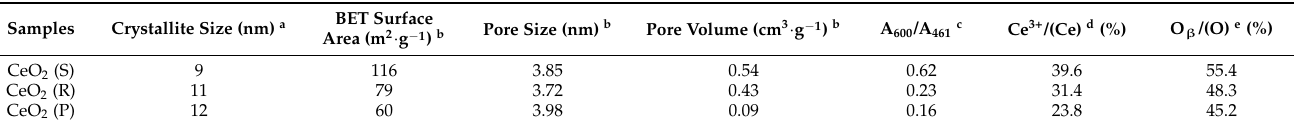
Figure 1. XRD patterns ( a ) and N 2 adsorption – desorption isotherms, BJH pore distribution (inset) ( b ) of CeO 2 (S), CeO 2 (R) and CeO 2 (P). Table 1. The XRD, BET, Raman and XPS results of CeO 2 (S), CeO 2 (R) and CeO 2 (P).